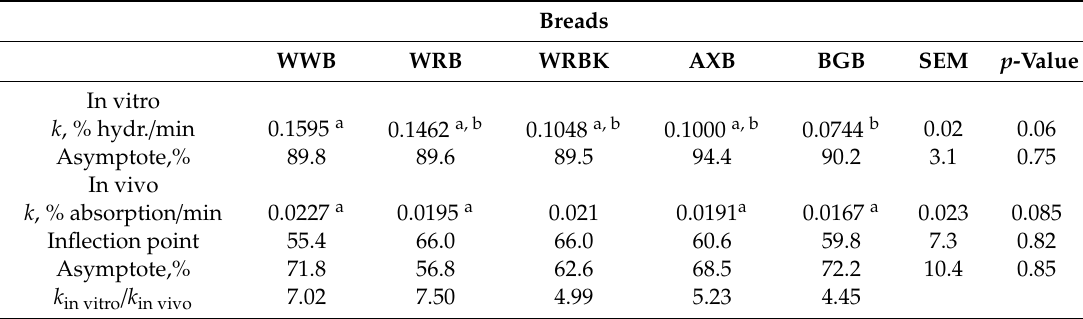
Table 2. In vitro and in vivo data of the digestion rate ( k ), asymptote and inflection point of breads varying in dietary fibre. Breads WWB